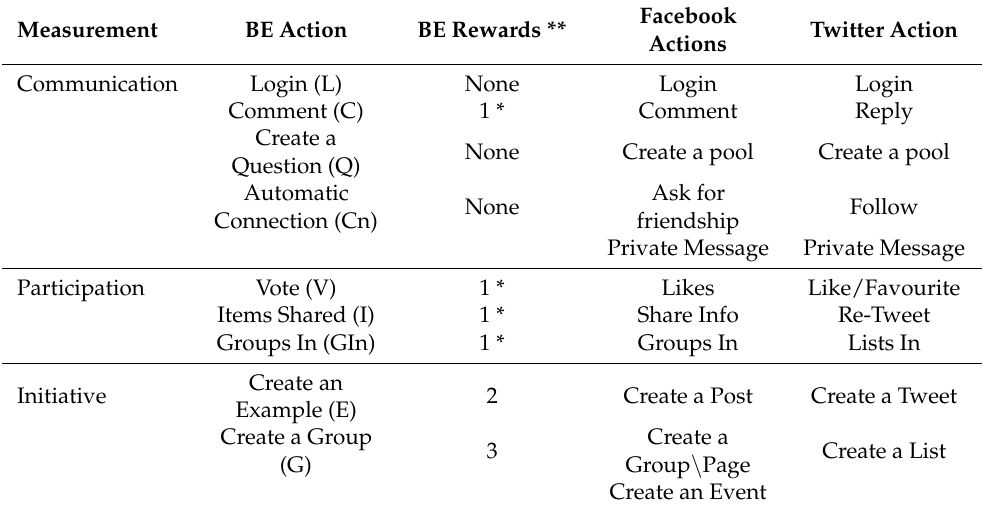
Table 1. BE rewards and comparison between Twitter, Facebook and BE